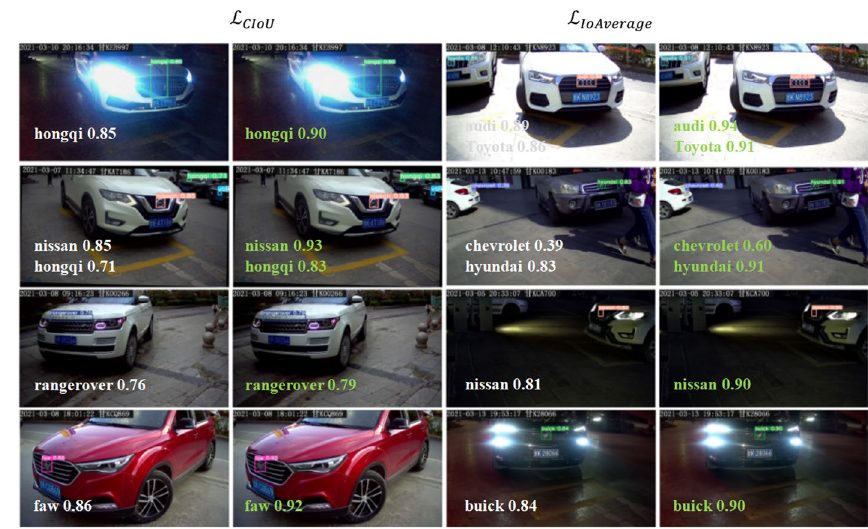
Fig. 9 Detection results using CIoU loss and IoAverage loss on the VLD100k-61